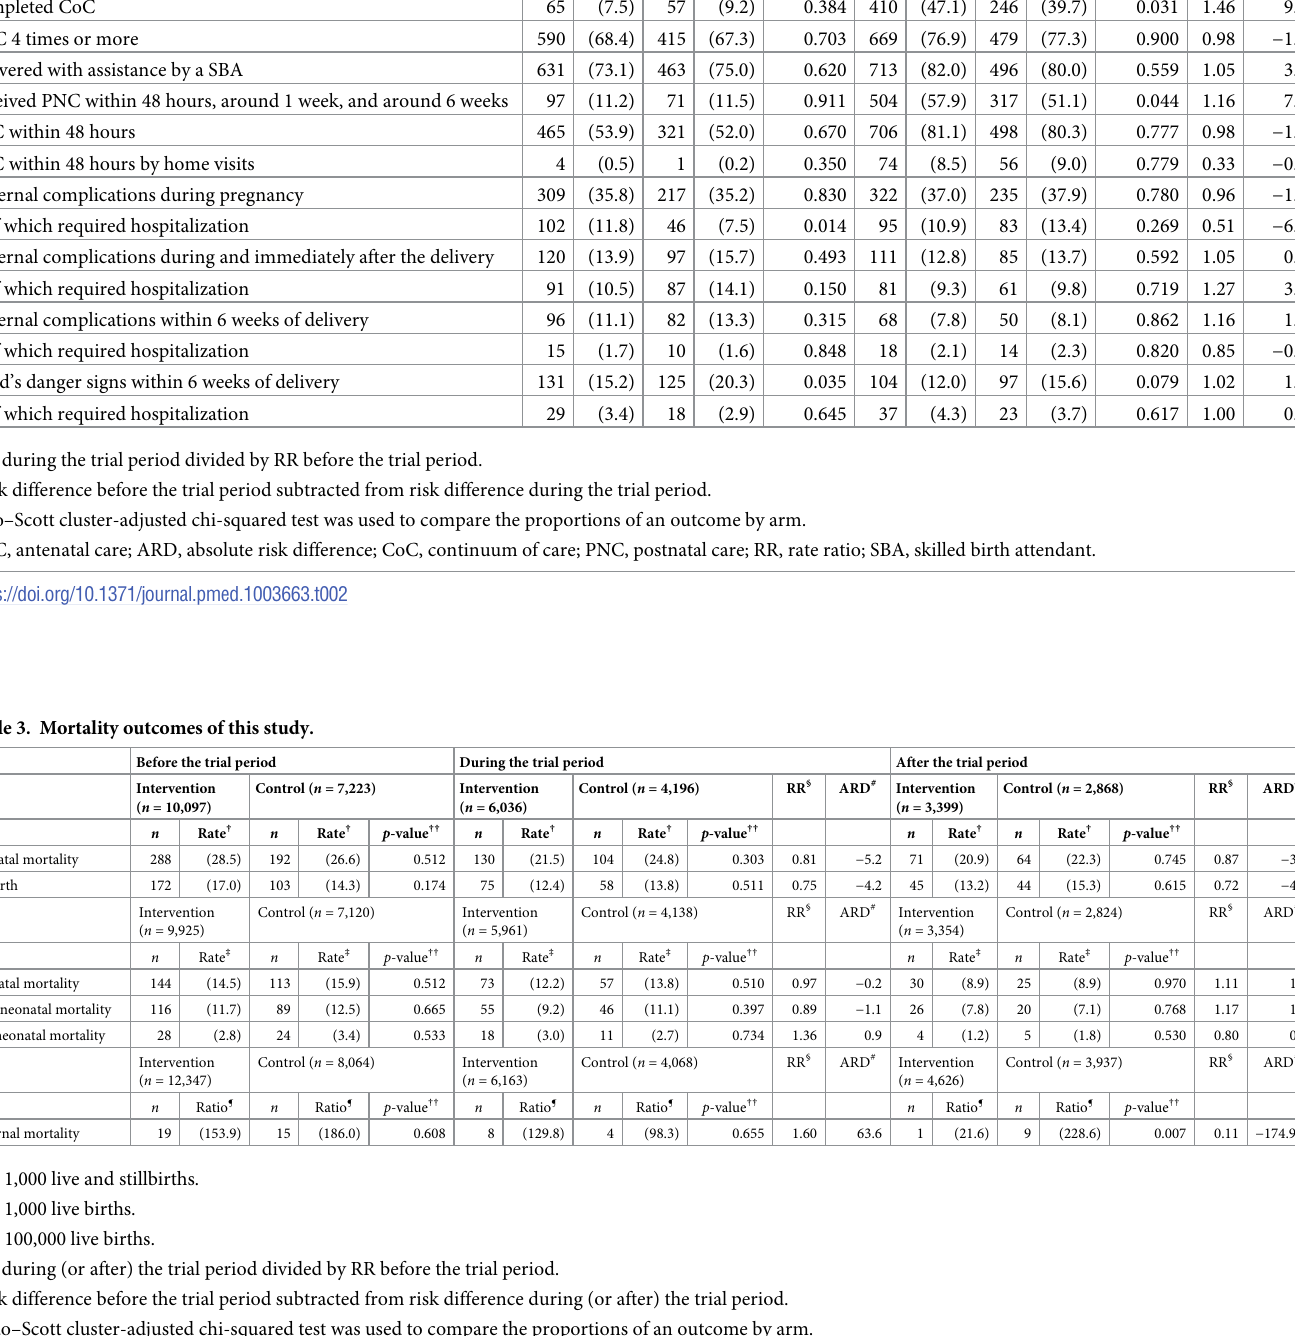
Before the trial period